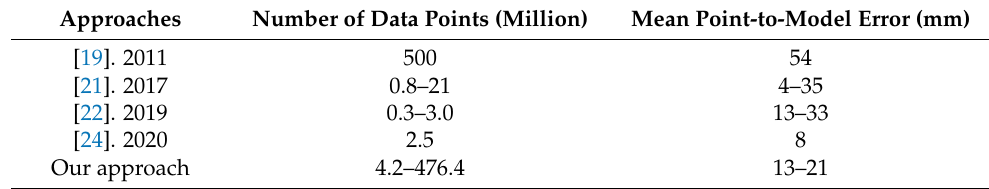
Table 2. Comparison of the mean point-to-model error between our approach and other methods. Approaches